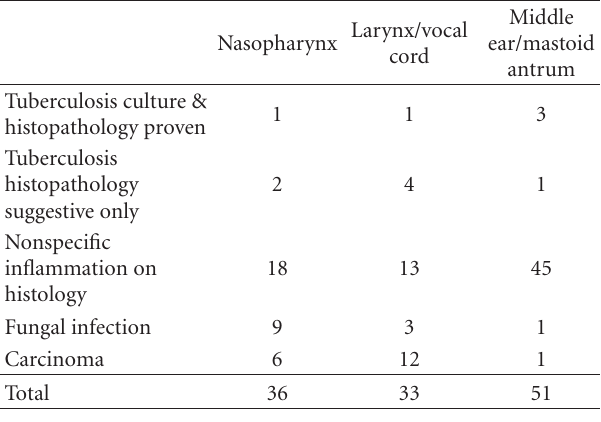
Table 1: Summary of the specimens received in the Mycobacteri- ology Section over 3 years with a suspicion of otorhinolaryngeal